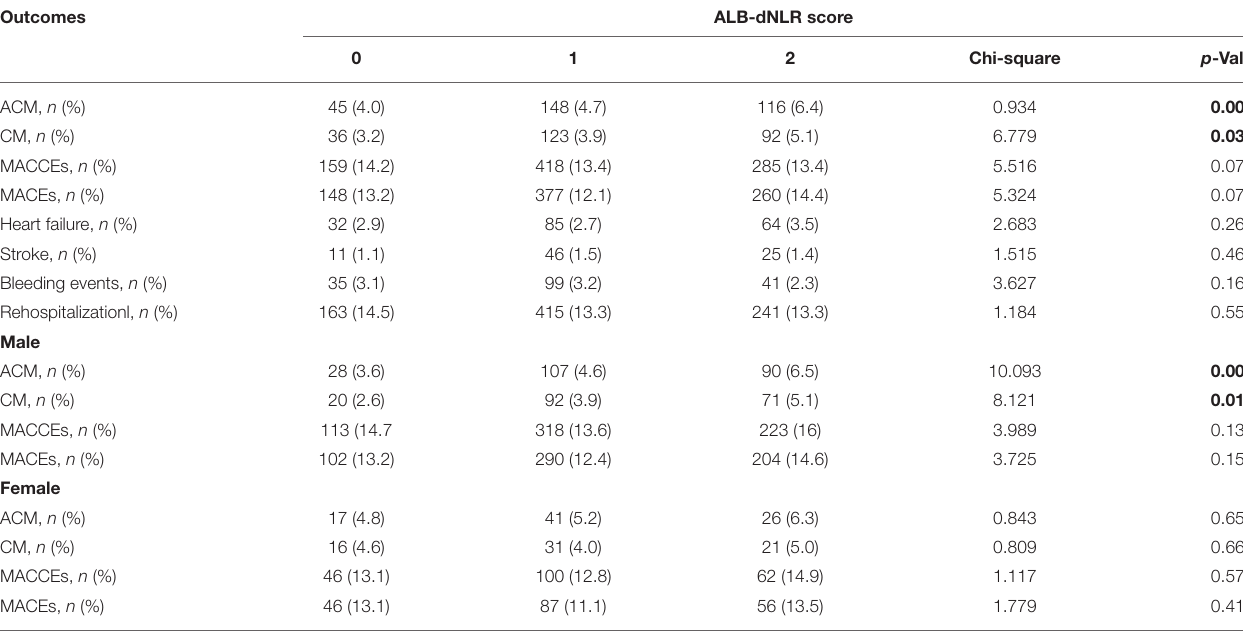
TABLE 3 | Outcomes comparison among three groups. Outcomes